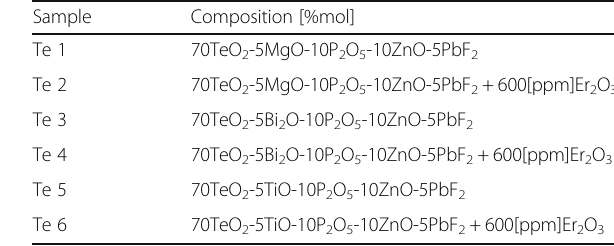
Table 1 Chemical composition of tellurite glasses